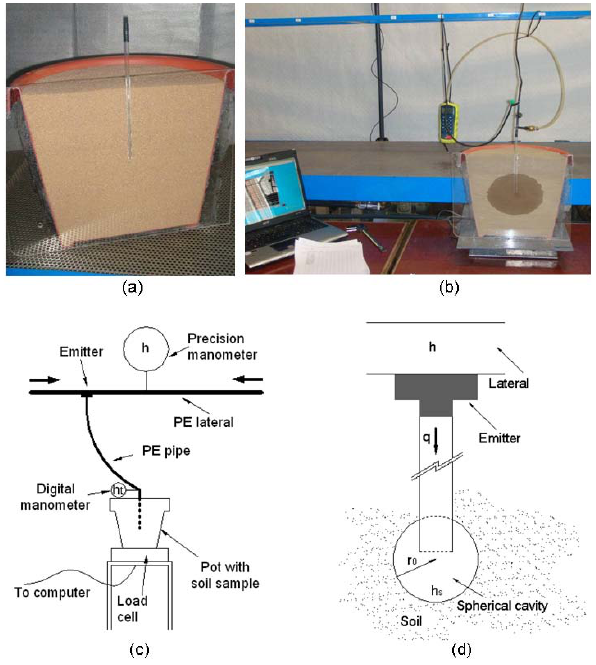
Fig. 1. Experimental procedure. (a) Cross-section of the pot; (b) Measurement setup; (c) Sketch of the installation; (d) Variables in- volved in the cavity